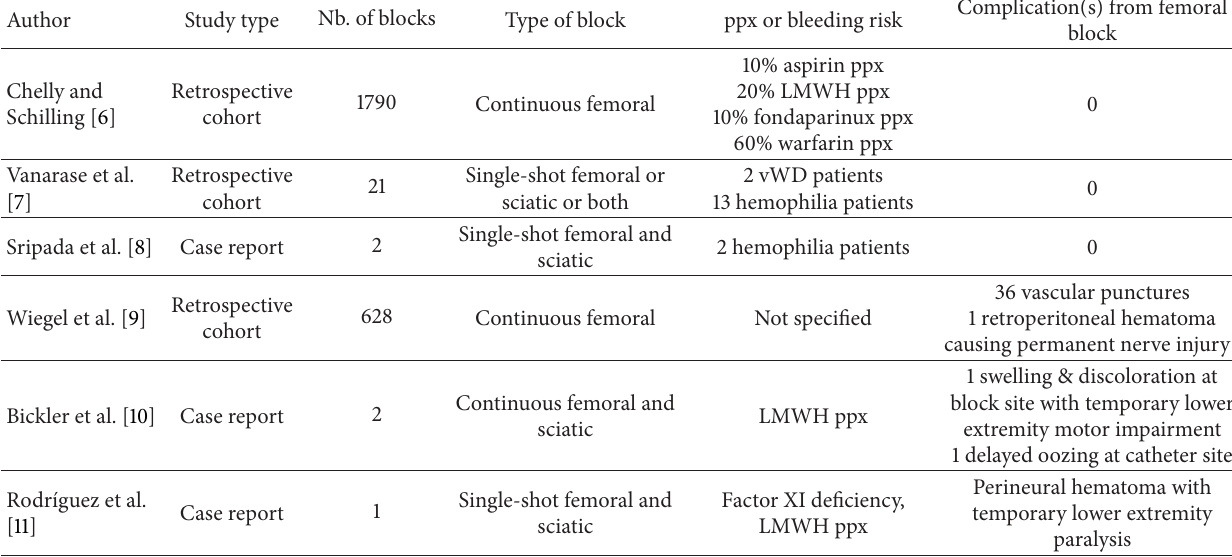
Table 1: Available literature on outcomes of femoral nerve blockade in patients on thromboprophylaxis and/or at above-standard bleeding